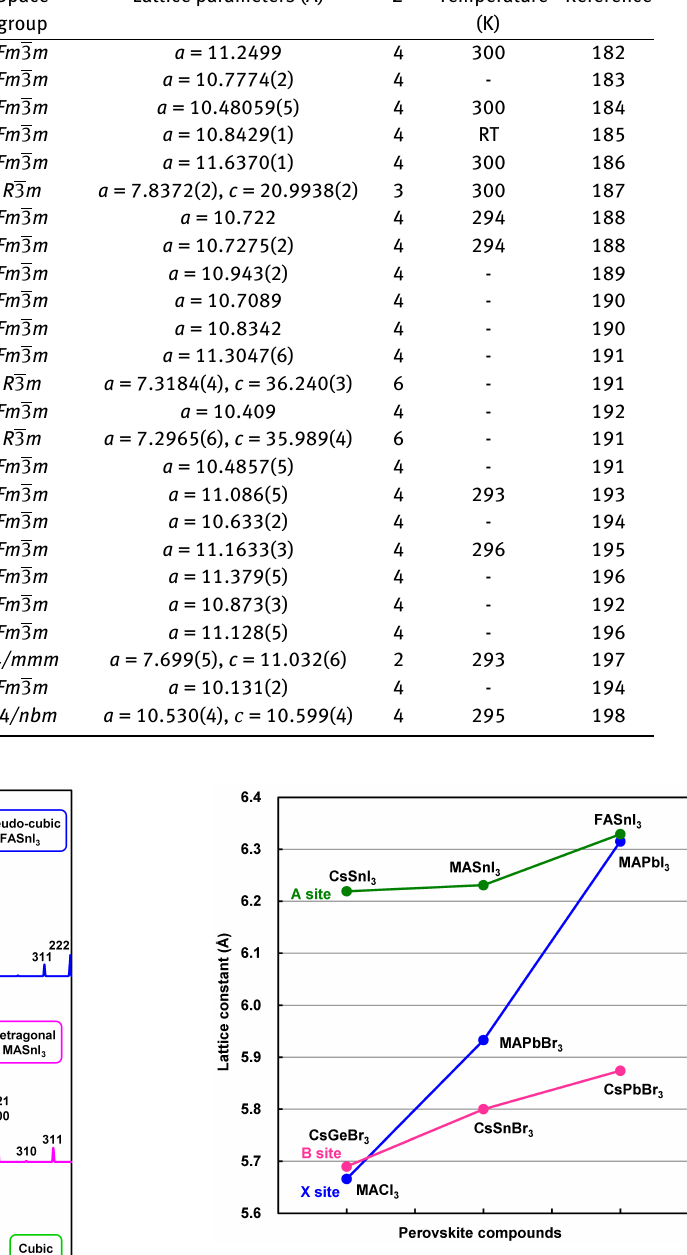
Figure 22: Lattice constants of various ABX 3 perovskite compounds. A = Cs, MA, or FA. B = Ge, Sn, or Pb. X = Cl, Br, or